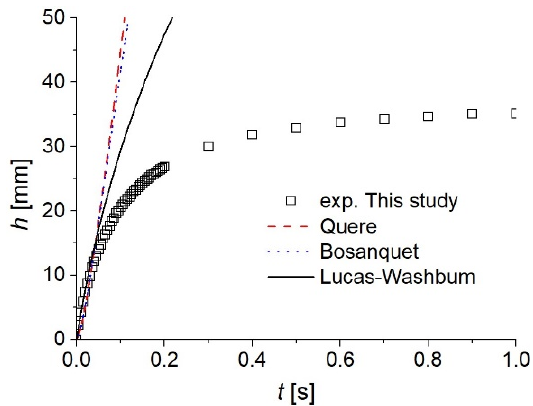
Figure 5. Variation of height ( h ) versus time ( t ) for the DW rise in capillary tube at test case of 2 r =